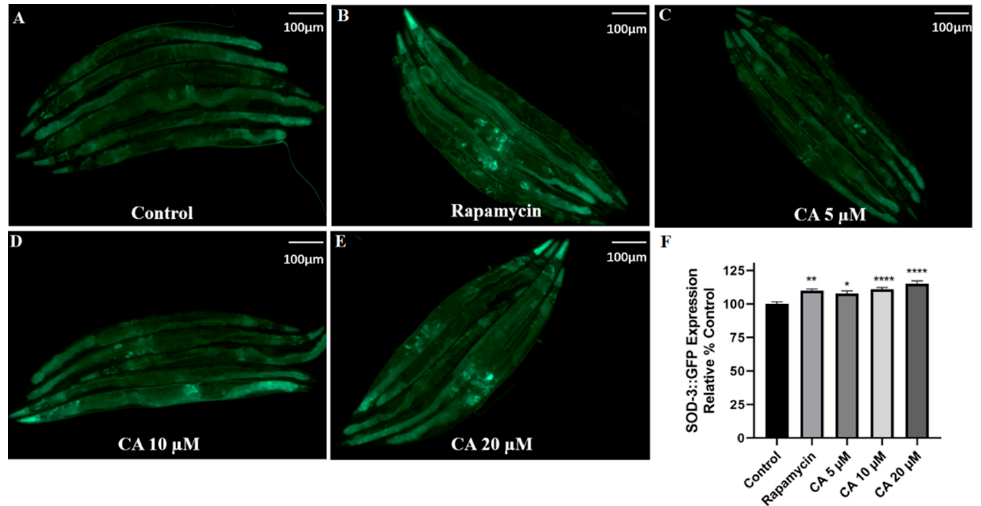
Figure 5. CA upregulates SOD-3 expression in C. elegans . Transgenic worms harboring SOD-3::GFP were treated without (control) or with rapamycin (2 nM) or CA (5, 10, 20 μ M) for 3 days. Representative images ( A – E ) of SOD-3::GFP expression in worms with different treatments, scale bar = 100 μ m. Quantification of SOD-3::GFP fluorescence intensity (( F ), n = 25, **** p ≤ 0.0001, ** p ≤ 0.01, * p ≤ 0.05 vs. control).